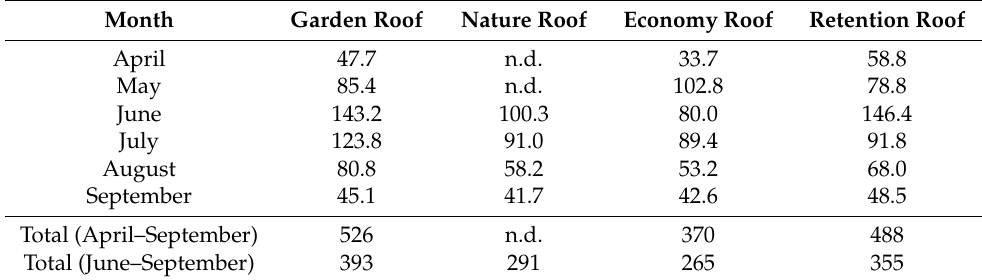
Table 2. Total monthly evapotranspiration [mm] 1